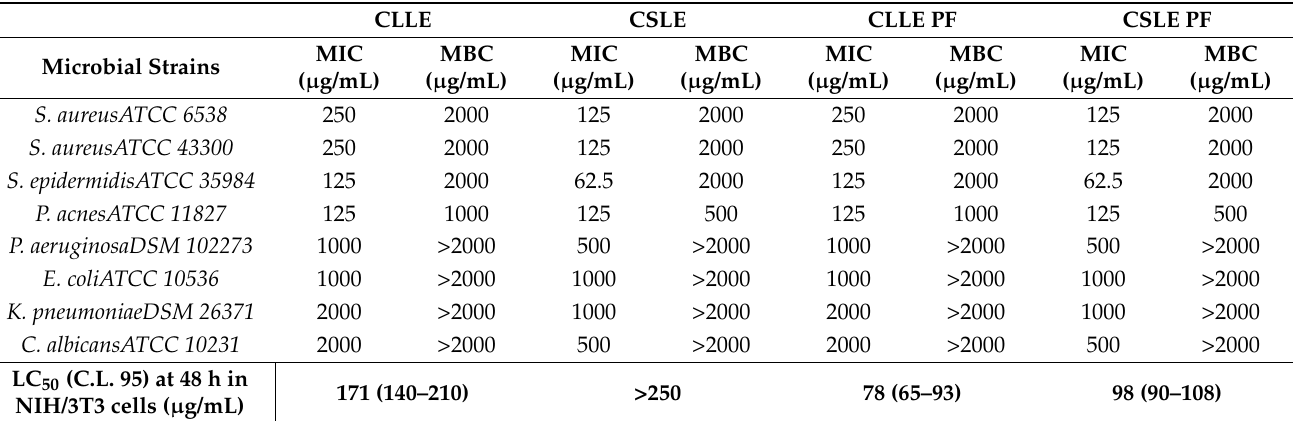
LC 50 (C.L. 95) at 48 h in 171 (140–210) NIH/3T3 cells ( µ g/mL) CLLE = Cistus laurifolius L. hydroalcoholic extract; CSLE = Cistus salviifolius L. hydroalcoholic extract; PF = polyphenol